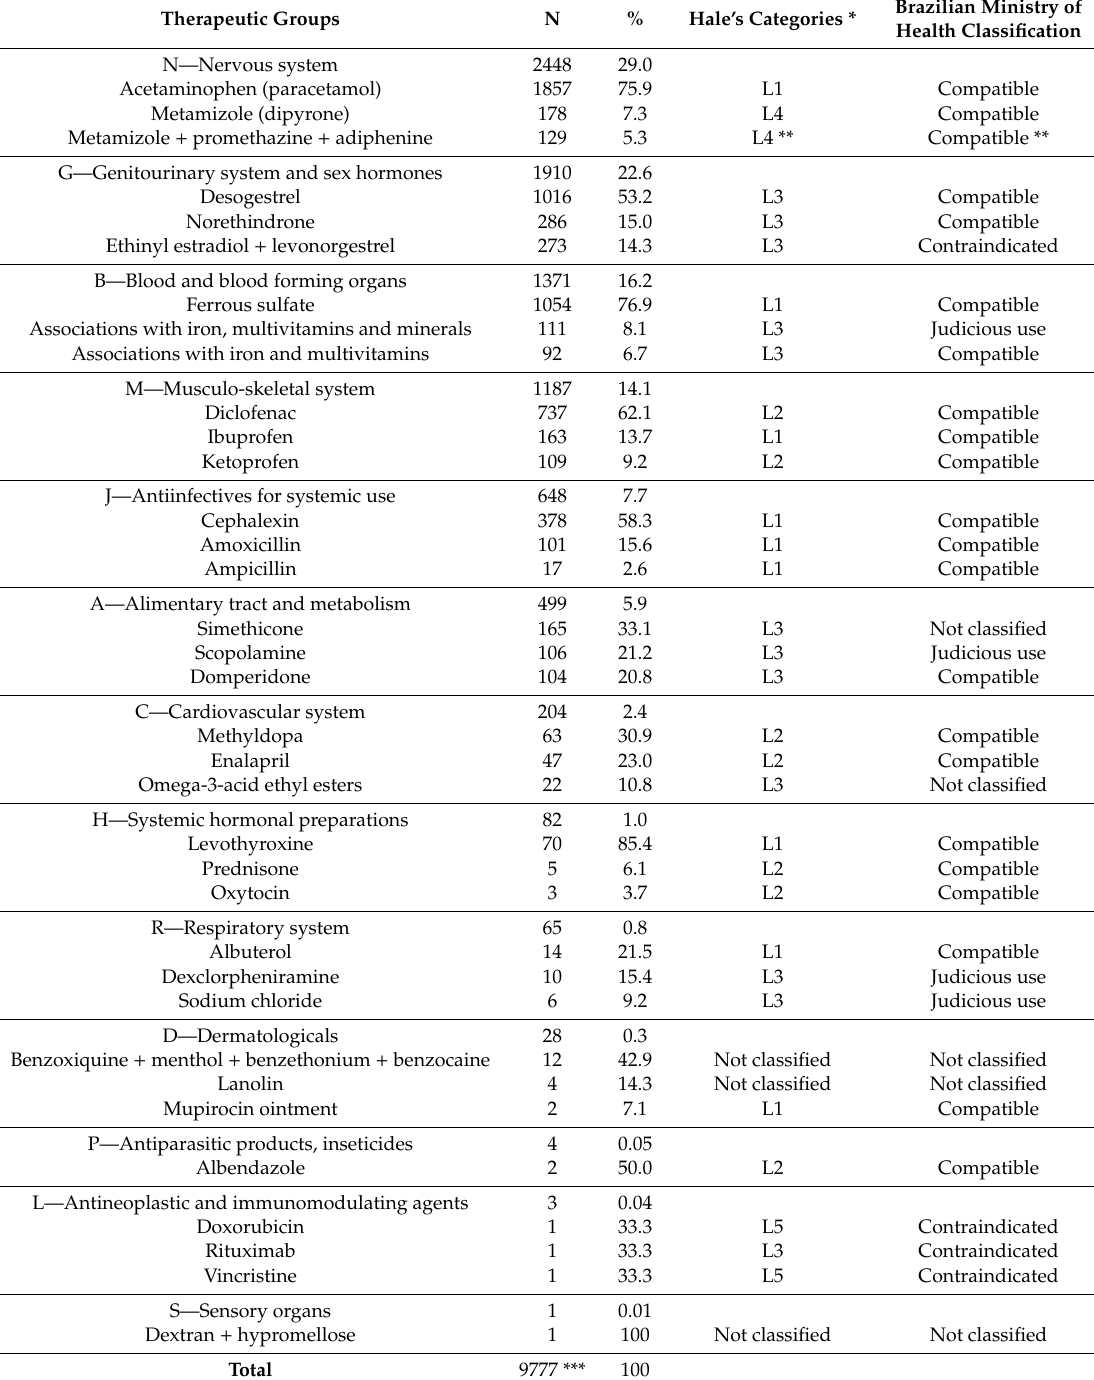
Table 2. Medications most commonly used during the first three months postpartum by breastfeeding women, based on The Anatomical Therapeutic Classification System [23], Hale’s Lactation Risk Categories [16] and Brazilian Ministry of Health Classification [17]. Pelotas (Brazil) Birth Cohort Study,